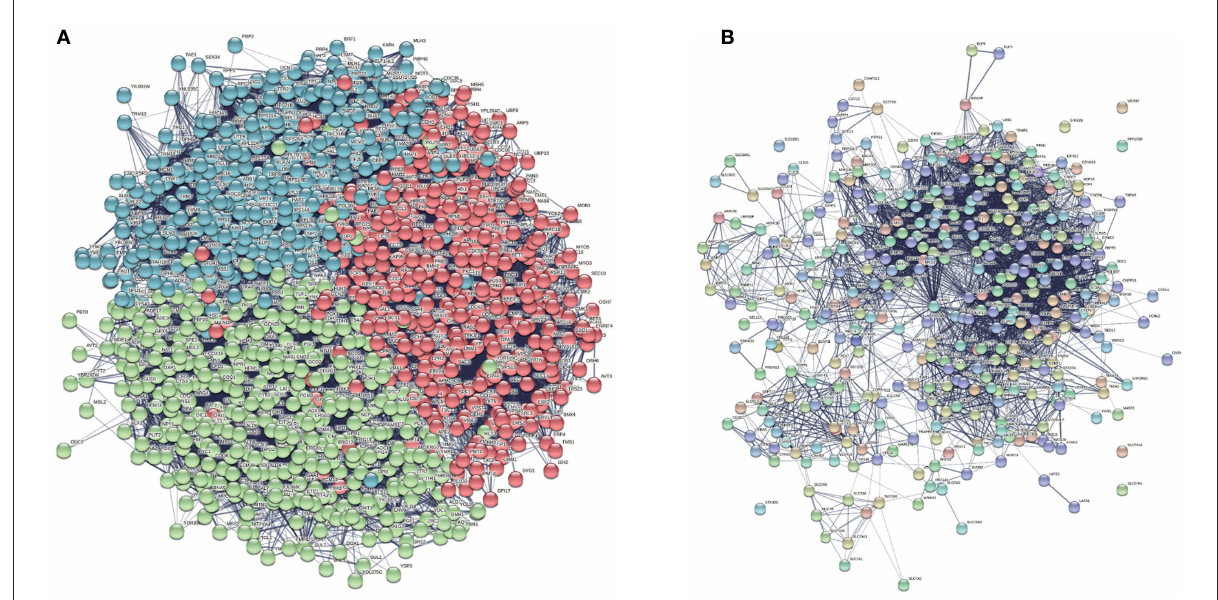
FIGURE8 We found a total of 1,166 proteins expressed by seed genes and obtained the interaction network between these Yeast proteins screening in the background Yeast PPI network. (A) Generated Yeast protein interaction network. (B) Clustered protein interaction network with nine